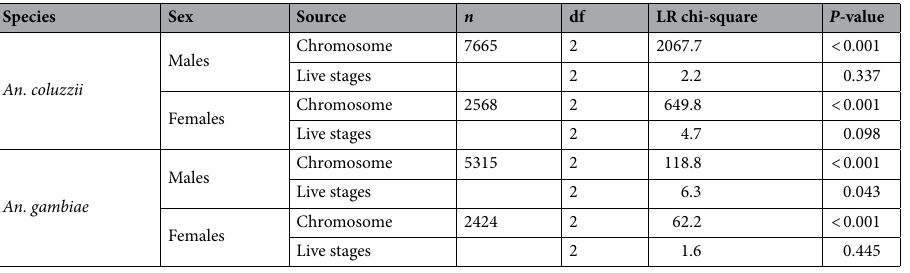
Table 4. Logistic regressions testing the effect of chromosome and life stage on frequencies of recombinant genotypes. The frequencies of introgressed X, 2L and 3L islands (entire islands) were compared among samples from larvae, adult resting indoors and swarming adults. Interactions were tested but not